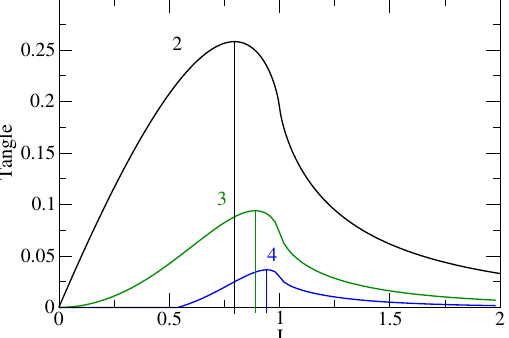
Figure 1. The entanglement between two, three, and four neighboring spins measured by the concurrence C 2 (black), the three-tangle τ (green), and the four-tangle τ 4 (blue) as a function of J . For the latter two, the 3 approximation (2) was used. They take their maximum values at ≈ . J 0 796 2max , ≈ . J 0 890 3max , and ≈ . J 0 94 4max , respectively – which shows the sequential increase of entanglement depth (avalanche of